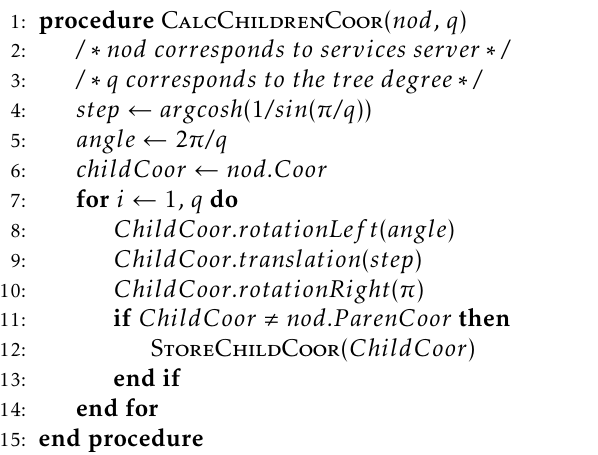
Algorithm 1 Coordinates’s computing of the Node’s children .